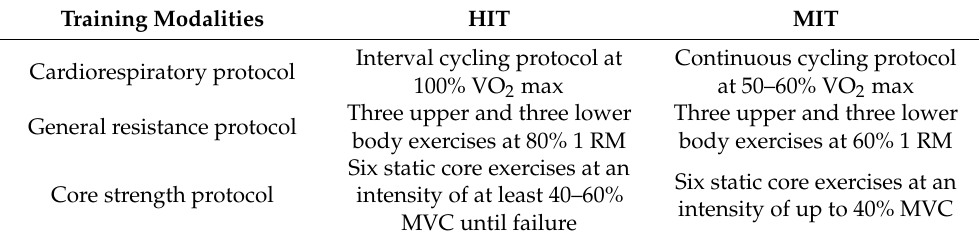
Table 1. Overview of the content of the intervention program for the experimental (HIT) and control (MIT) group. Training Modalities HIT MIT Interval cycling protocol at Continuous cycling protocol Cardiorespiratory protocol 100% VO 2 max Three upper and three lower General resistance protocol Six static core exercises at an Six static core exercises at Core strength protocol intensity of at least 40–60% MVC until failure